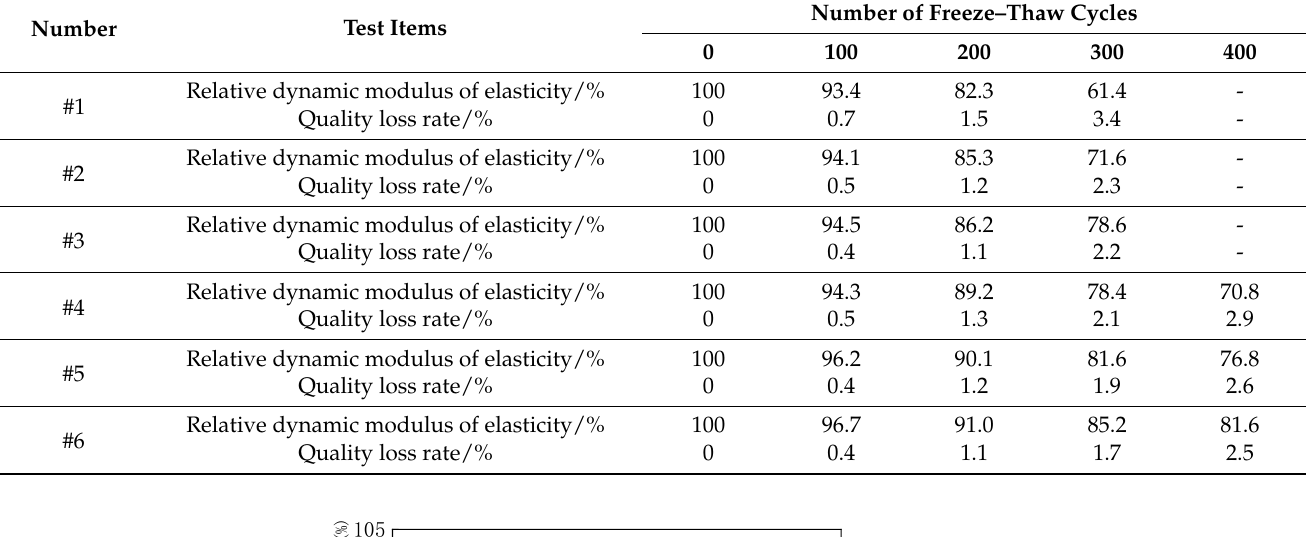
Table 6. Concrete frost resistance test results.